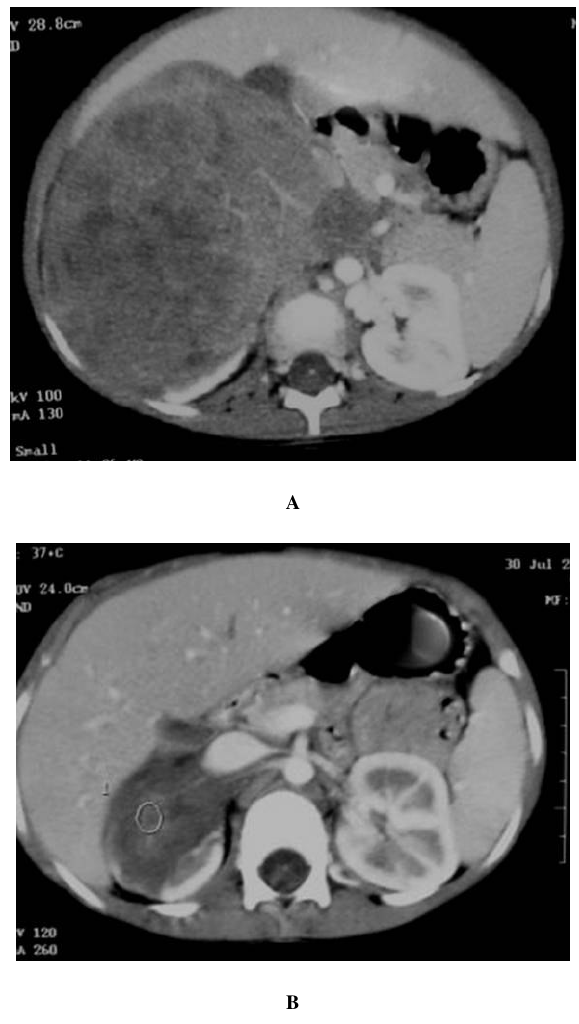
FIGURE 3. CT findings in a 6-year-old girl with right WT. (A) Preoperative scan shows a large renal mass with nonopacified IVC; (B) 6 weeks after chemotherapy, there is marked reduction in the size of the mass with resolution of the IVC